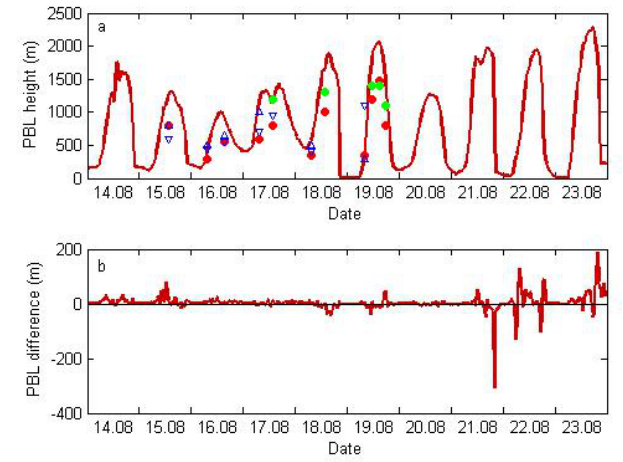
Figure 6. ( a ) The simulated (with CORINE land-cover data) boundary layer (PBL) height defined via turbulent kinetic energy (TKE) (red line), the simulated (with CORINE land-cover data) PBL defined via relative temperature and absolute air humidity (g·kg − 1 ) (red filled circle), the defined PBL via relative temperature and absolute air humidity from the aircraft measured values for up/down spiral (triangle up/down), maximum height of flight (green filled circle). ( b ) The difference in boundary layer height estimation between CORINE and RAMS land-cover data (RAMS values—CORINE